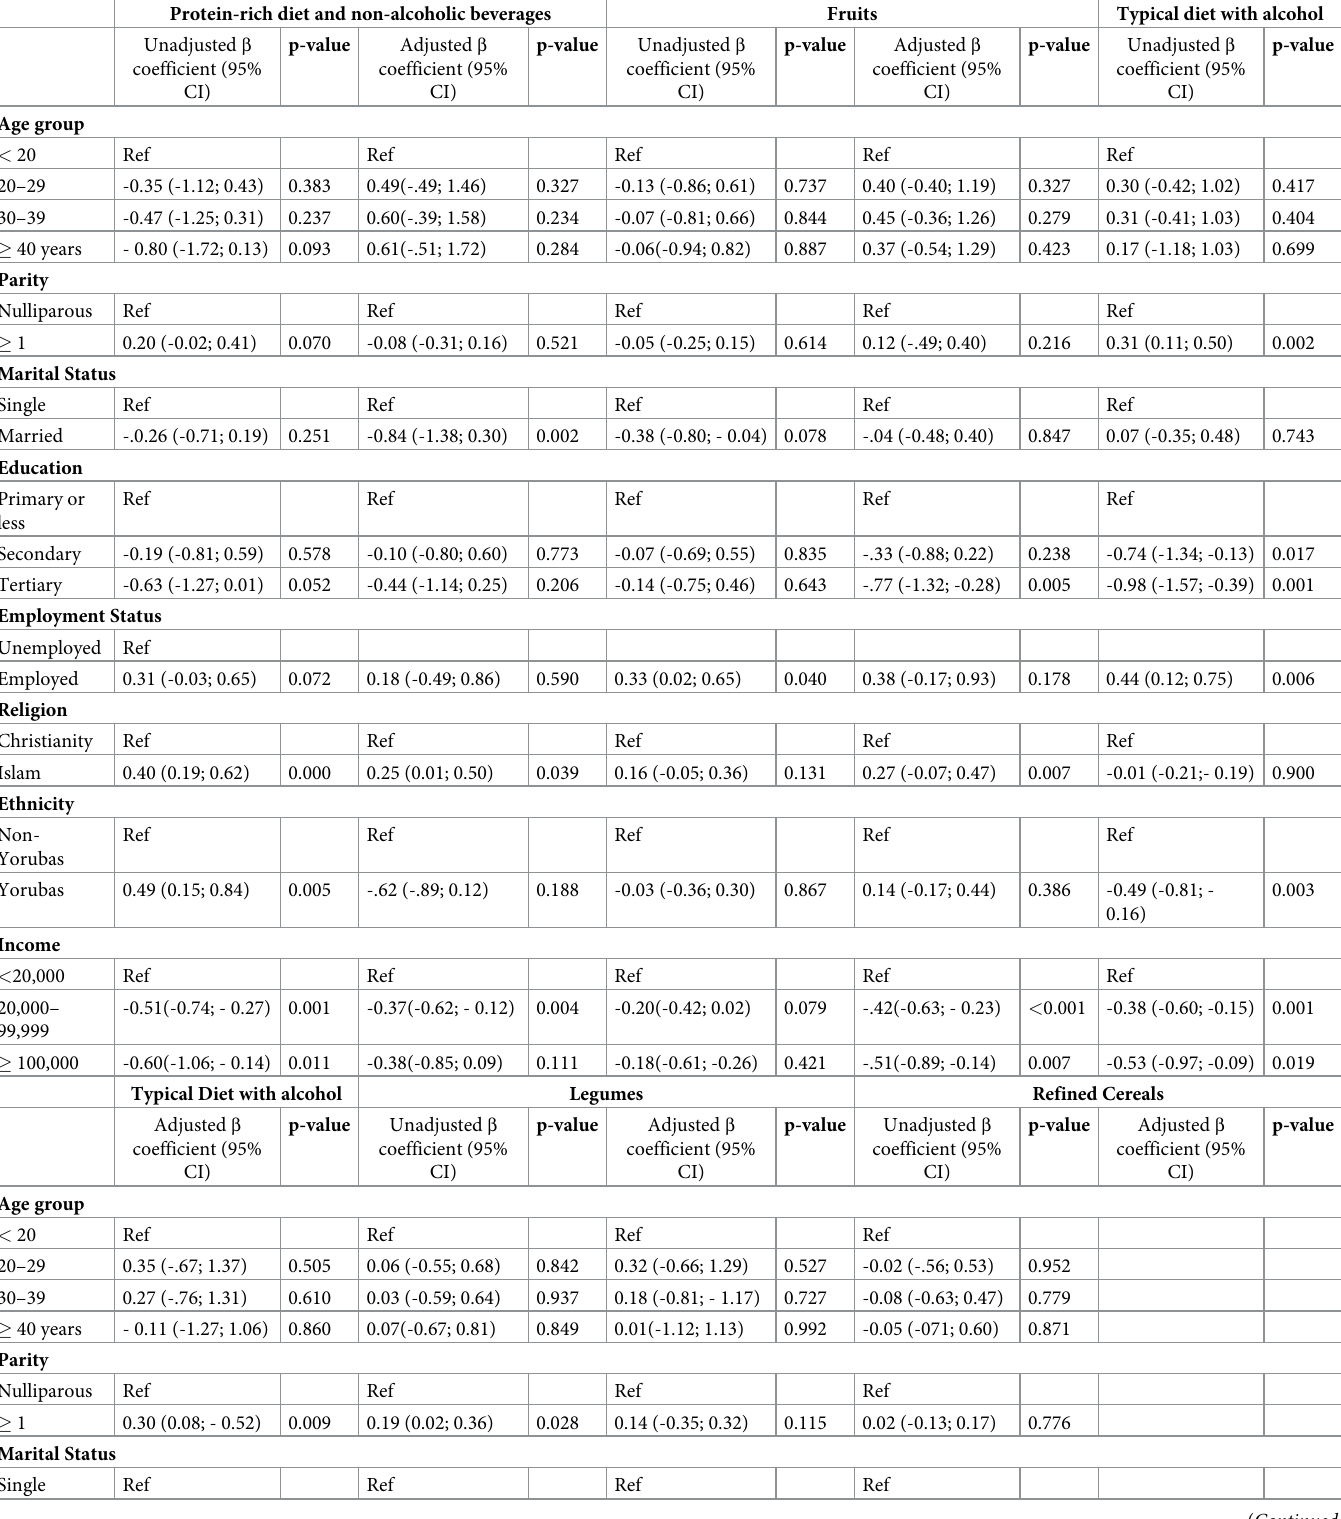
Table 5. Modelling the participants’ sociodemographic characteristics and dietary patterns. Protein-rich diet and non-alcoholic beverages Fruits Typical diet with